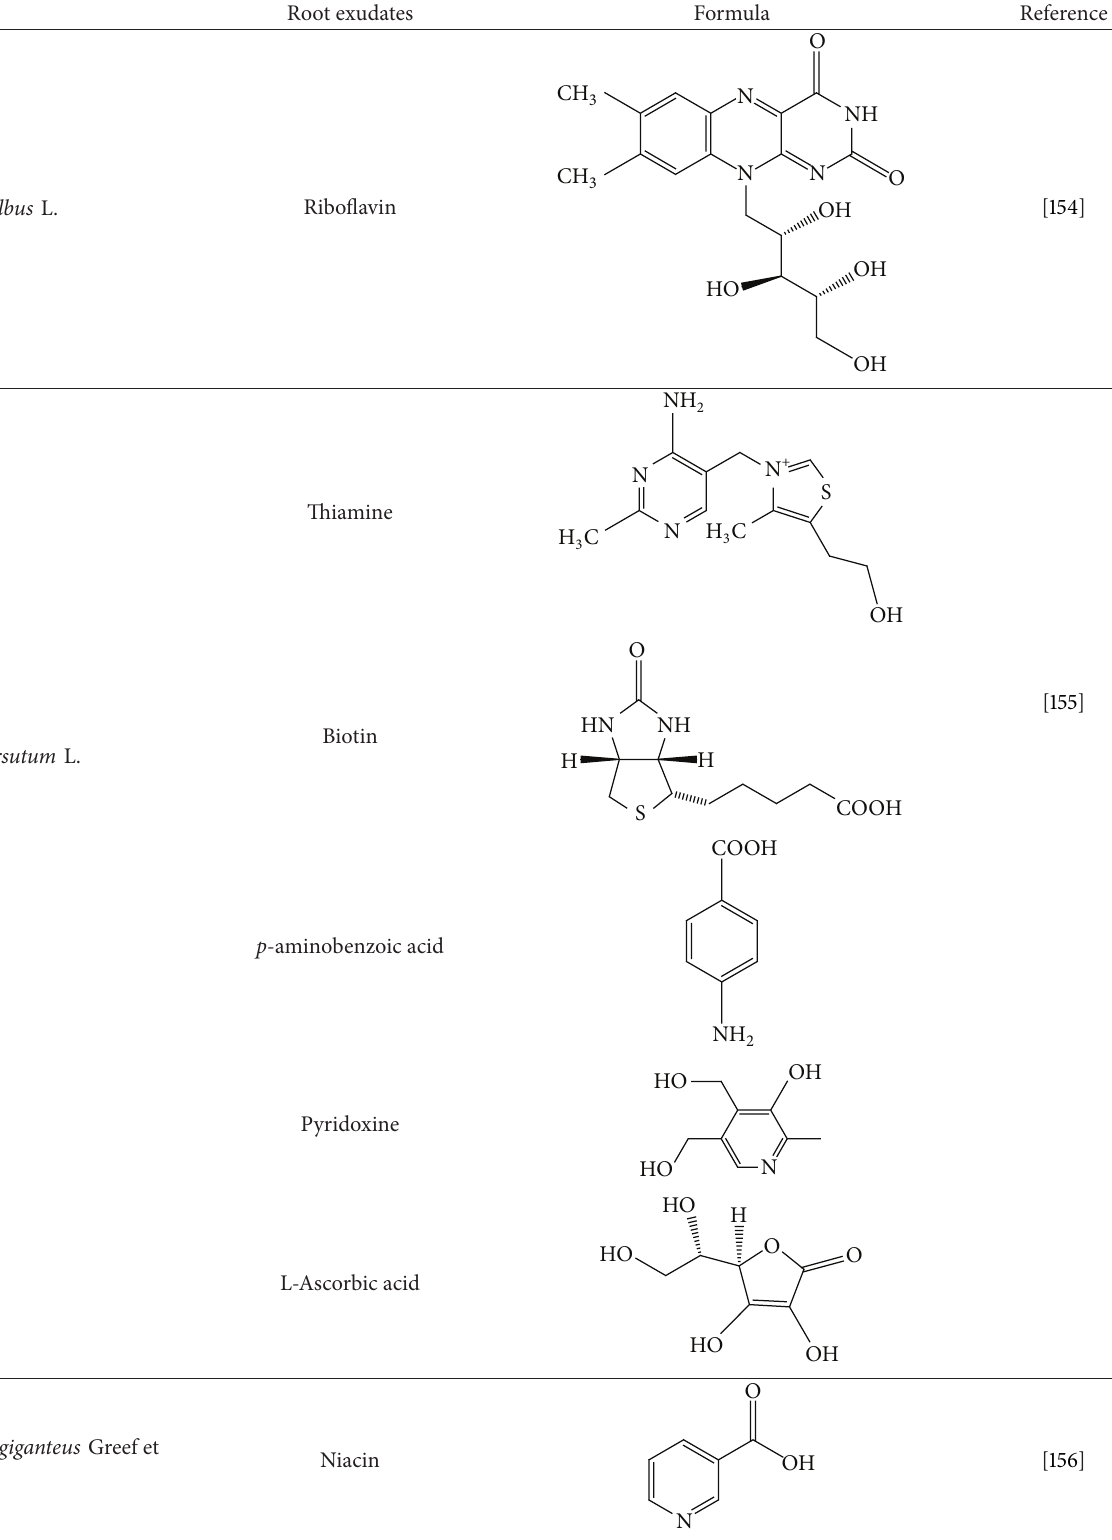
Table 3: Vitamins in plant root